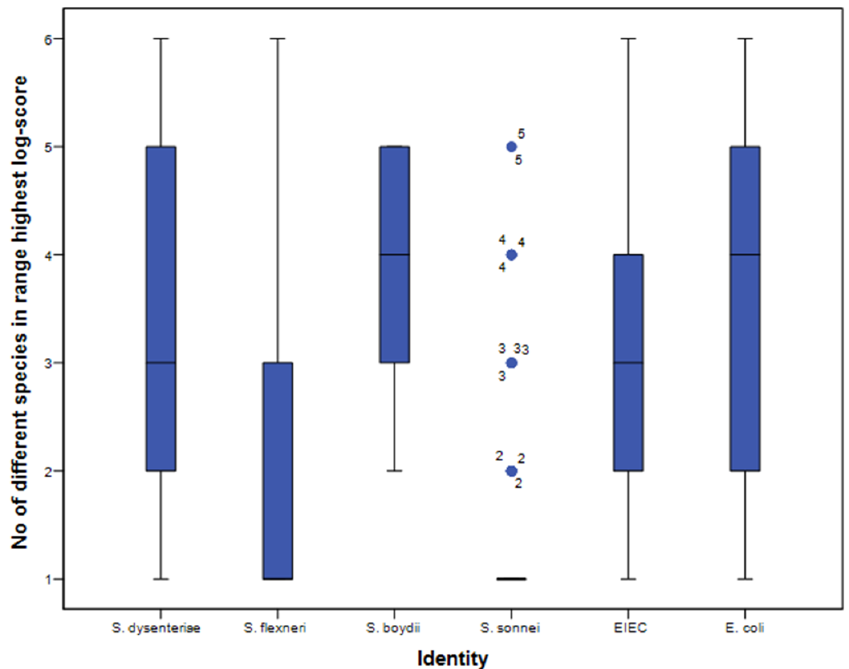
Figure 3. Number of different species in the first 10 matches per spot with the direct smear method. Identity (x-axis) was assigned using the culture-based identification algorithm. Black horizontal bars represent the median number of species; the 25–75% interquartile ranges are indicated by the blue vertical bars, and 5–95% intervals by the black vertical lines. Outliers are indicated with blue